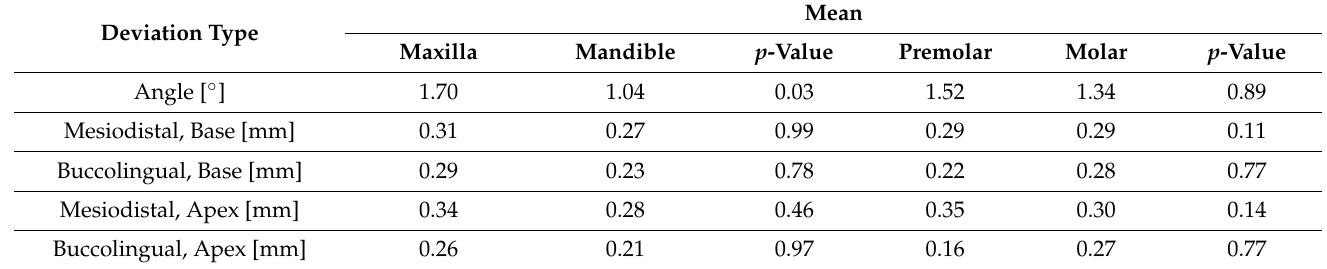
Table 2. Mean angle deviation ( ◦ ) and deviation in the mesio-distal and bucco-oral direction (mm) at the base and tip of the bur between maxillary vs. mandibular and premolar vs. molar teeth.